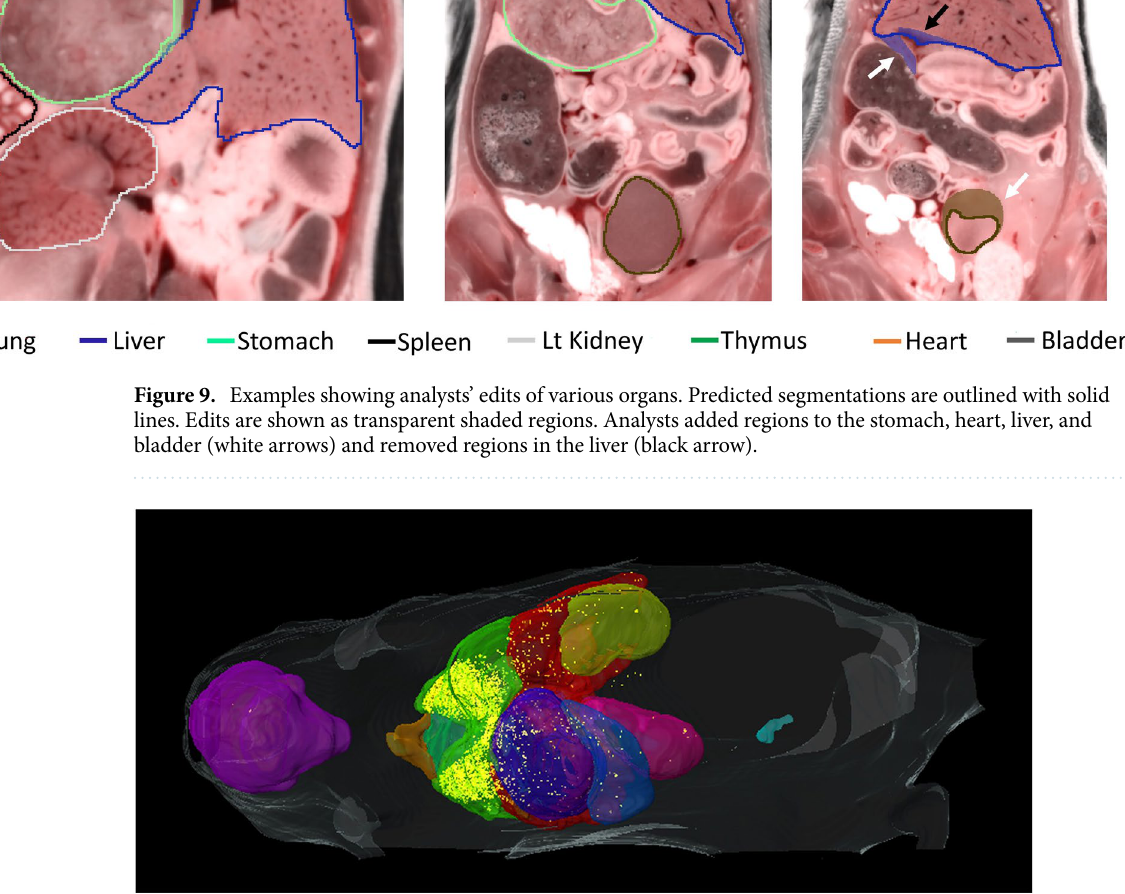
Figure 10. 3D visualization of MSC distribution in a mouse with acute liver injury induced by CCl4. Detected MSCs are surface rendered in yellow. There were 22,797 MSCs, with 19,656 in the lung, 2082 in the liver, 70 in the spleen, seven in the heart, 12 in the left kidney, two in the right kidney, none in the brain, stomach, thymus, or bladder, and 968 in the rest of the mouse body. The quantifications based upon manual segmentations were: 18,935 in the lung, 2081 in the liver, and 67 in the spleen, giving a smaller than 5% disagreement. Our fully automated analysis provides a means for quick and thorough analysis of distribution to a much larger number of organs than is practical with manual